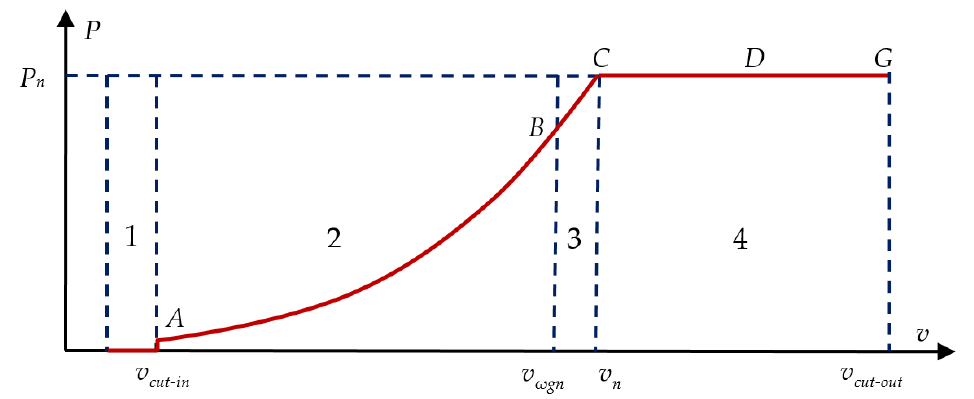
Figure 3. Basic operating characteristic of a wind turbine (WT) mechanical output power versus the wind speed divided into operating regions.